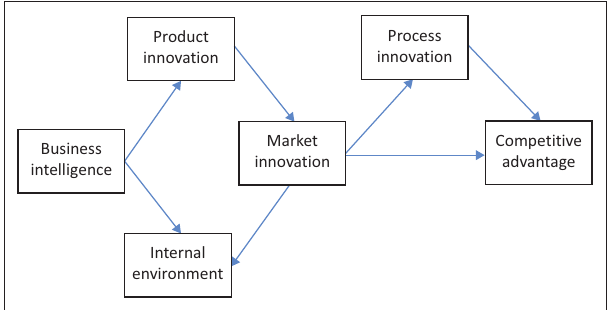
FIGURE 4: Proposed framework for innovative business intelligence.